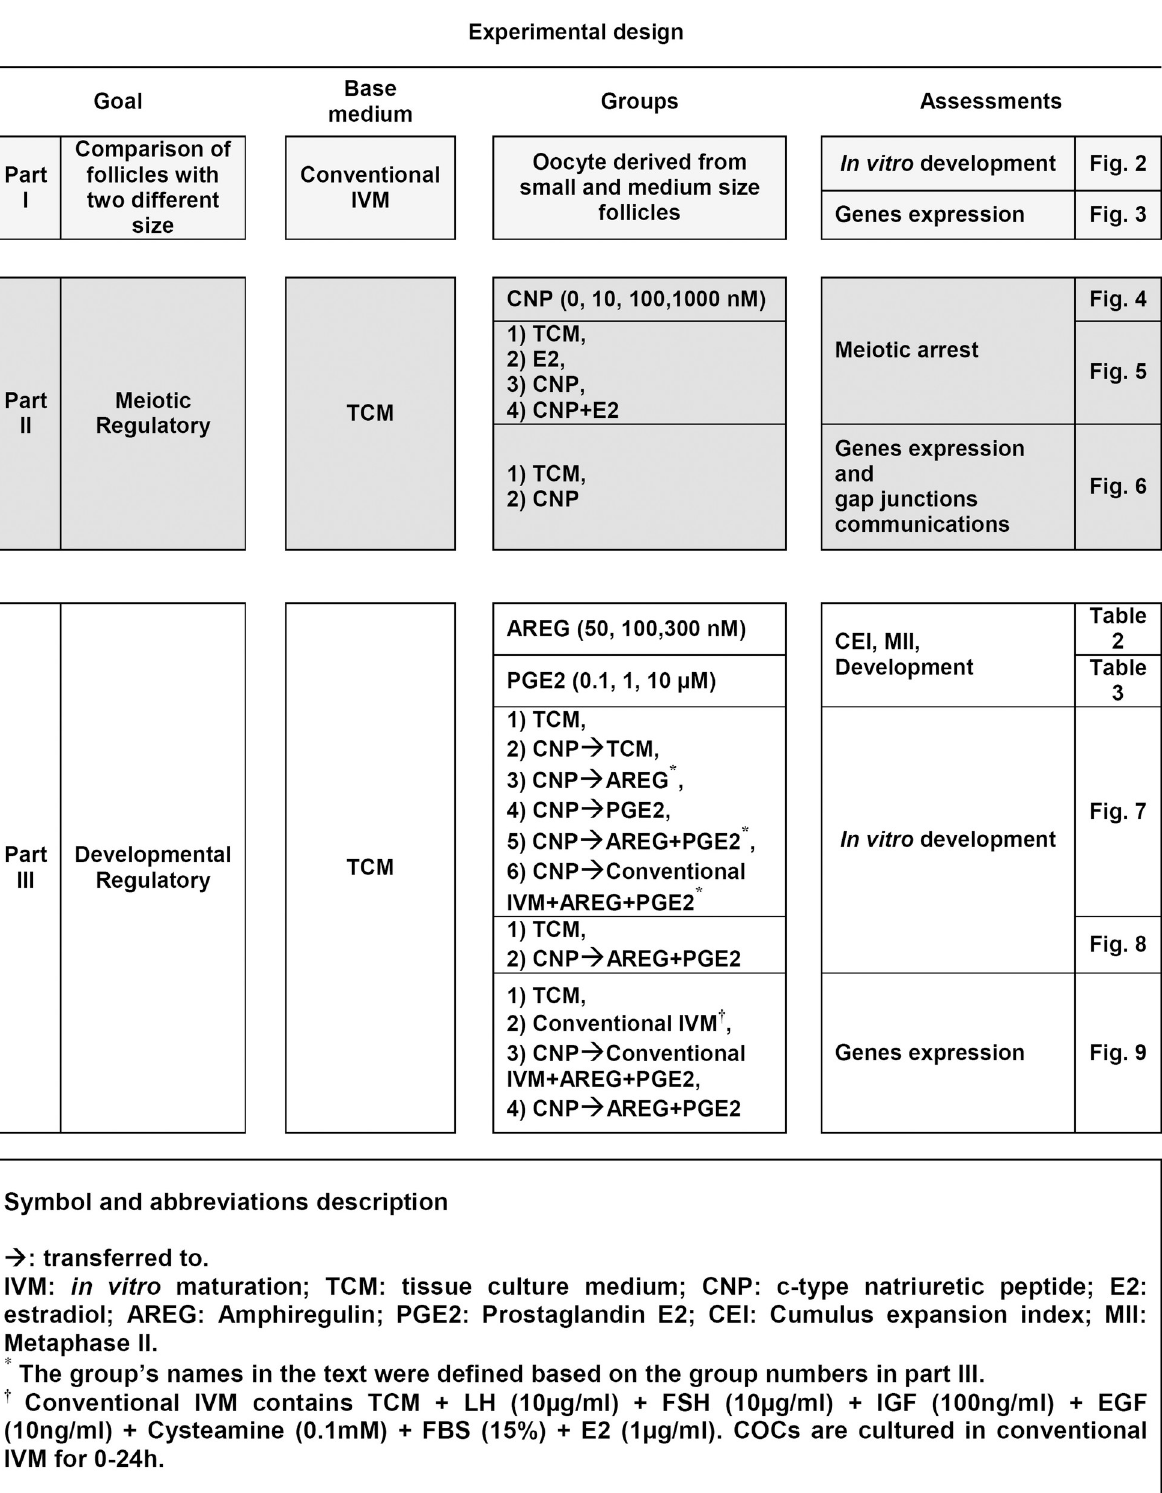
Fig 1. Experimental design.